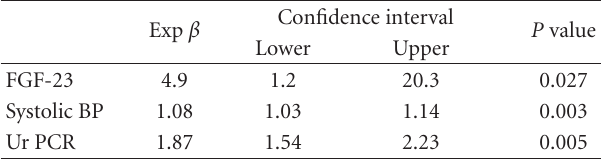
Table 3: Multivariate analysis model showing significant predictors of LVH in patients with